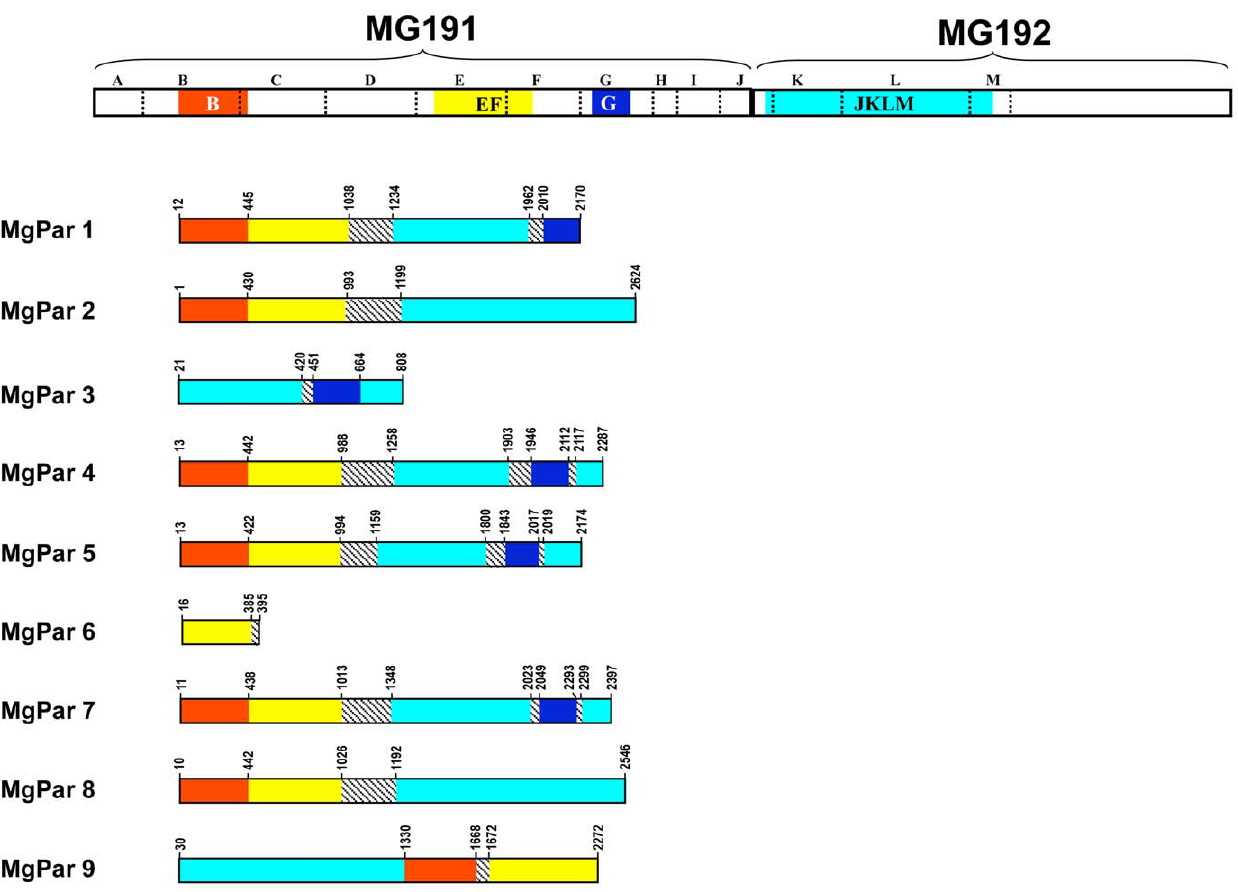
Figure 2. Schematic representation of sequence homology of the MG191 and MG192 genes with MgPars based on the M.genitalium G37 genome (GenBank accession number NC_000908). Divisions A through M indicated by dotted vertical lines represent the restriction fragments described previously [13,31]. The four repeat regions B, EF, G and JKLM are highlighted in colors (consistent with colors used in Fig. 1). Homologous regions between MG191/MG192 and MgPars are indicated in identical colors. The hatched box represents intervening sequences that are unusually A-T rich and contain stop codons. The numbers bordering each segment of each of the MgPars refer to the nucleotide positions in the full-length MgPars as described elsewhere [10]. The line length in the diagrams is not always proportional to the number of nucleotides involved due to the presence of minor deletions/insertions. MgPars found in clinical strains involved in this study showed the same architecture but divergent sequences (with different coordinates for each region shown) compared to G37 MgPars.